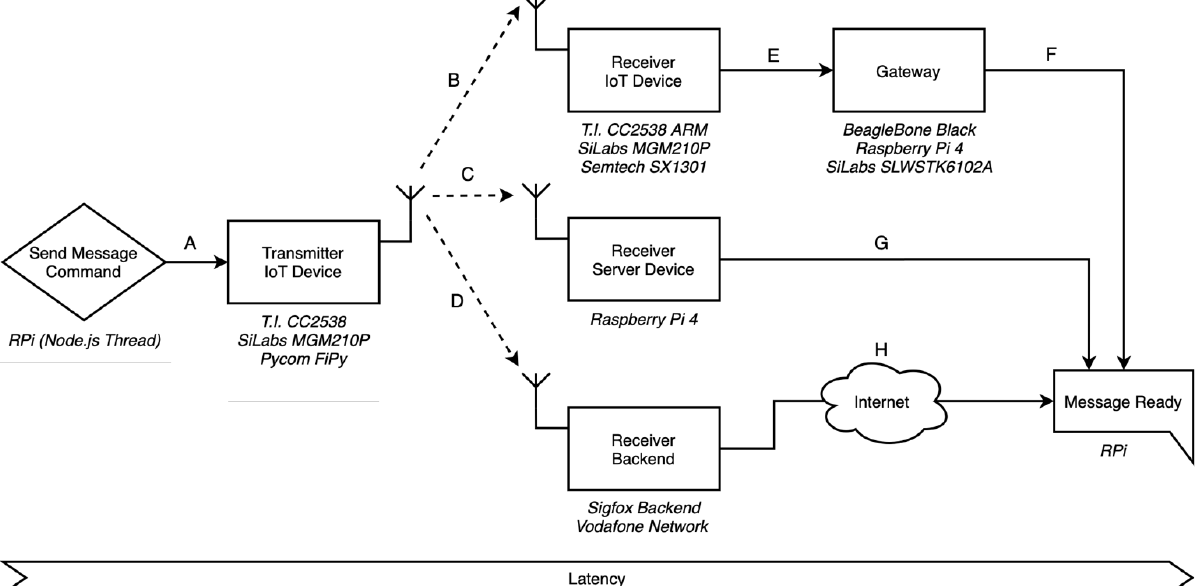
Figure 1. Latency : abstract definition and message paths for different wireless IoT topologies. These paths, along with the designated physical IoT devices—which are all compliant with the IoT tech- nology of interest—actually portray the very use case deployed in the lab to do this work. Other configurations could be also used for certain technologies and other devices as well.